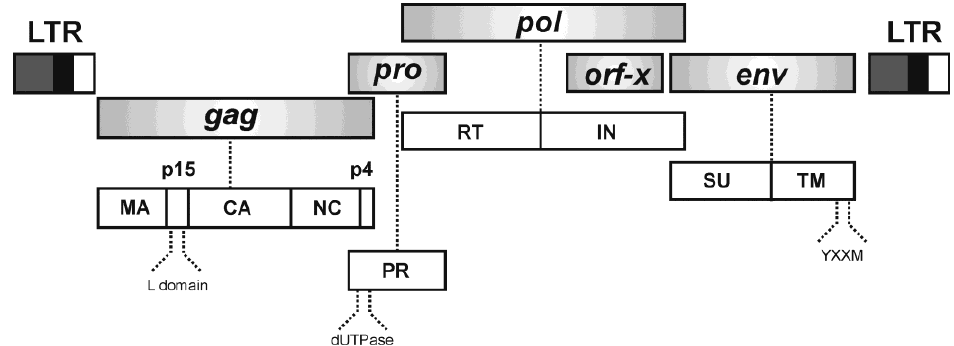
Figure 1. JSRV genomic organization. The JSRV genome encodes gag , pro , pol and env genes and orf-x , an additional open reading frame of unknown function (top). On the bottom are indicated the polyprotein precursors derived from each gene that are cleaved by the cellular machinery. See text for more details. LTR, long terminal repeat; MA, matrix; p15, 15 kDa protein; L domain, late domain; CA, capsid; NC, nucleocapsid; p4, 4 kDa protein; PR, protease; dUTPase, deoxyuridine triphosphatase; RT, reverse transcriptase; IN, integrase; SU, surface domain; TM, transmembrane domain; YXXM, Y indicates a tyrosine residue, X any amino acid and M a methionine residue (according to the single-letter